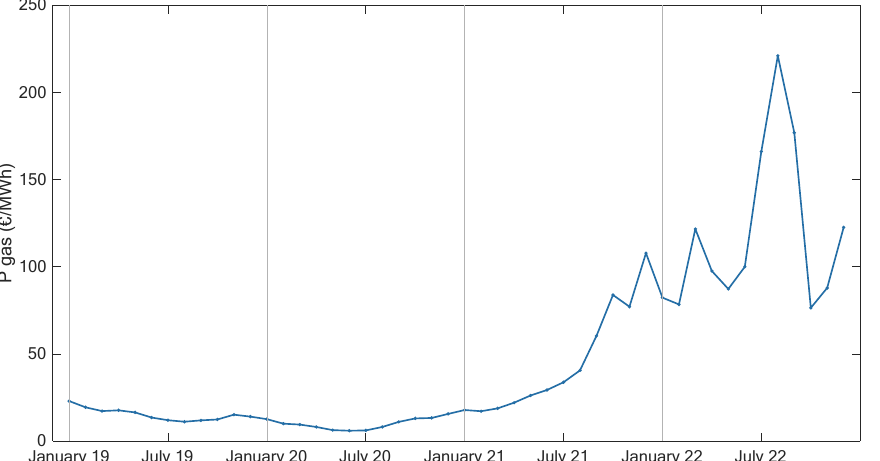
Figure 4. Average monthly prices of natural gas, values from Italian gas DAM.